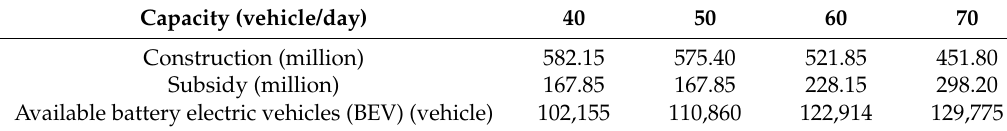
Table 1. The best arrangements of the budget under each capacity.